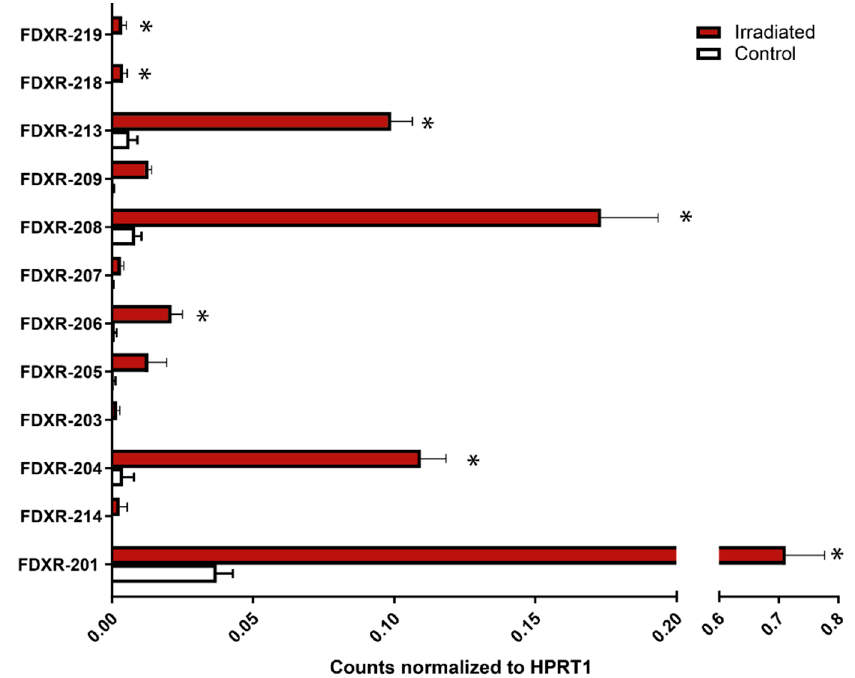
Figure 6. Variants identified by nanopore sequencing. Blood samples were expose to a 2 Gy dose (0.5 Gy/min) and incubated at 37 °C for 24 h. RNA was extracted and poly A+ enriched before preparing the library using a cDNA-PCR kit (PCS109). The sequencing was performed in a PromethION (Oxford Nanopore Technologies). Counts were normalized by HPRT1. Data are shown as mean ± SEM ( n = 3). Statistical analyses were performed in log-transformed data. Significant differences (paired t -test, p ≤ 0.05) with the control were indicated with an asterisk